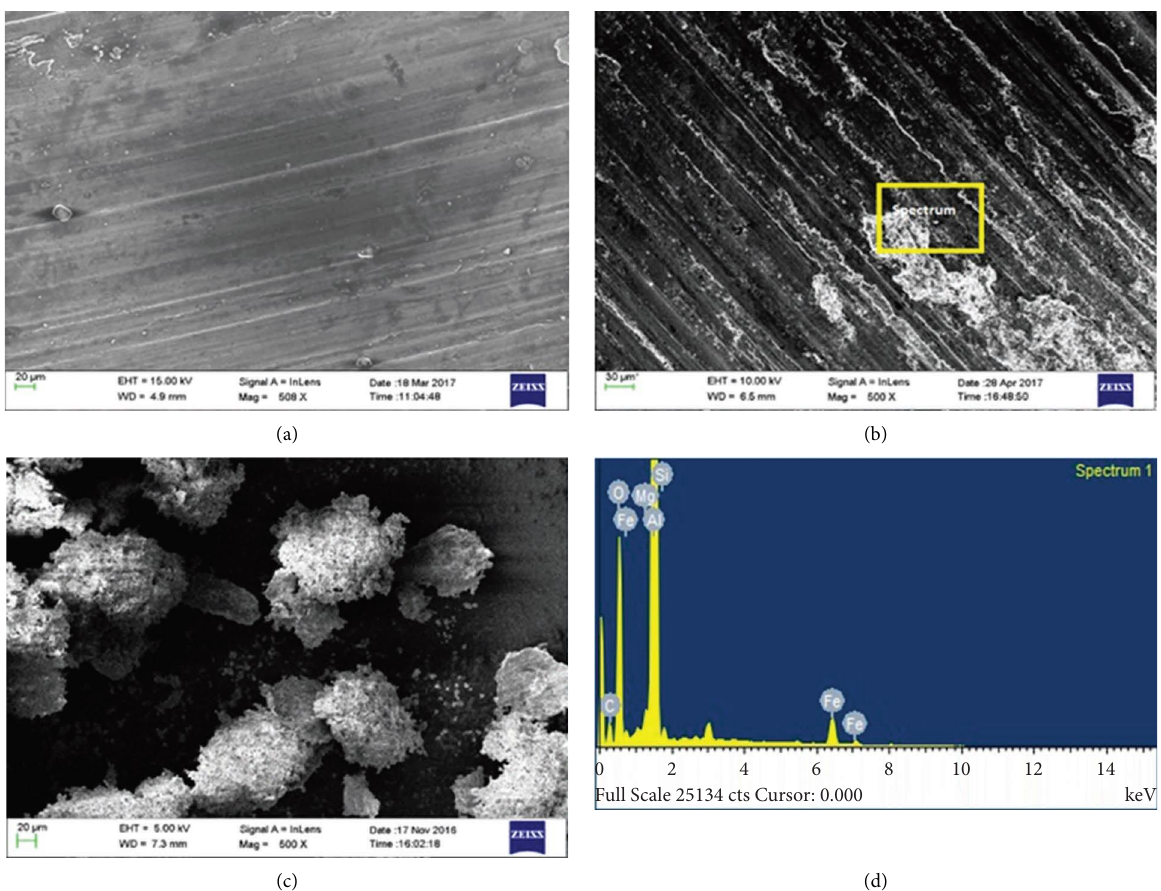
Figure 10: SEM image of the worn surface of Al/0.4SiC/0.5Gr: (a) 10 N, (b) 40N, (c) wear debris particles of Al/0.4SiC/0.5Gr under a load of 40N, and (d) EDS result of